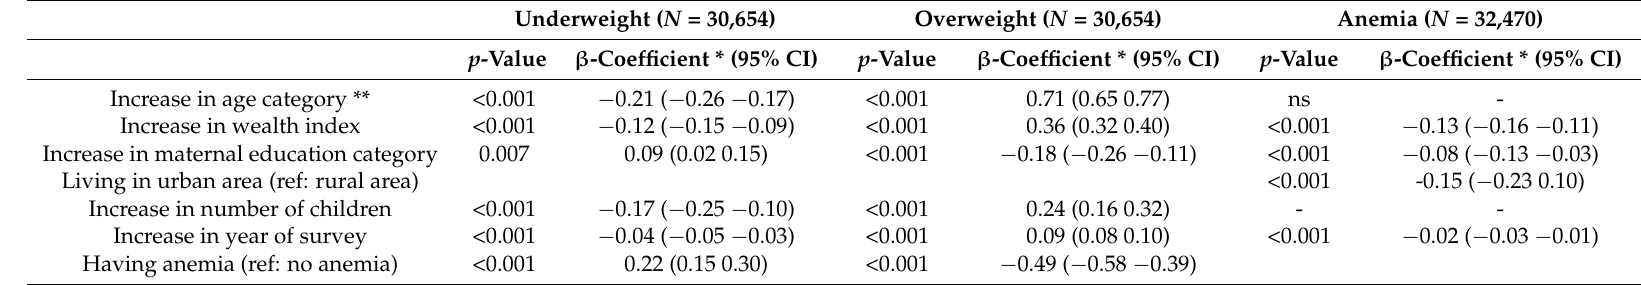
Table 5. P -value and regression coefficients of factors contributing to underweight, overweight, and anemia prevalence in Cambodian women in the four DHS